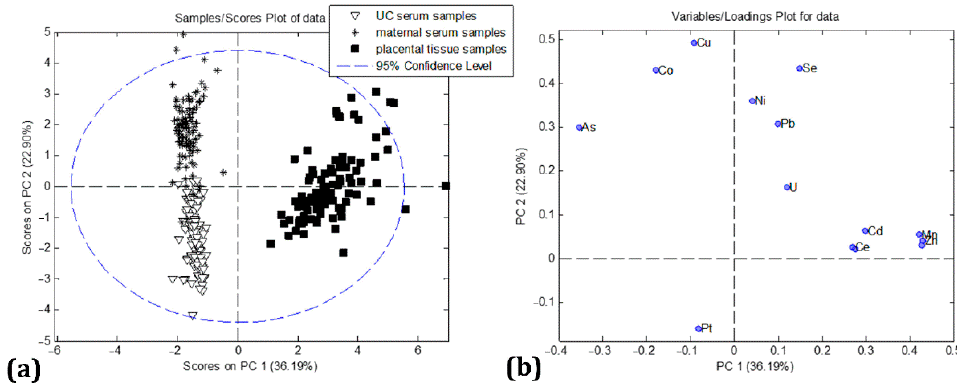
Figure 2. PCA model: ( a ) the score plot, ( b ) the loading plot for analyzed trace metals in maternal serum, placental tissue, and UC serum samples.